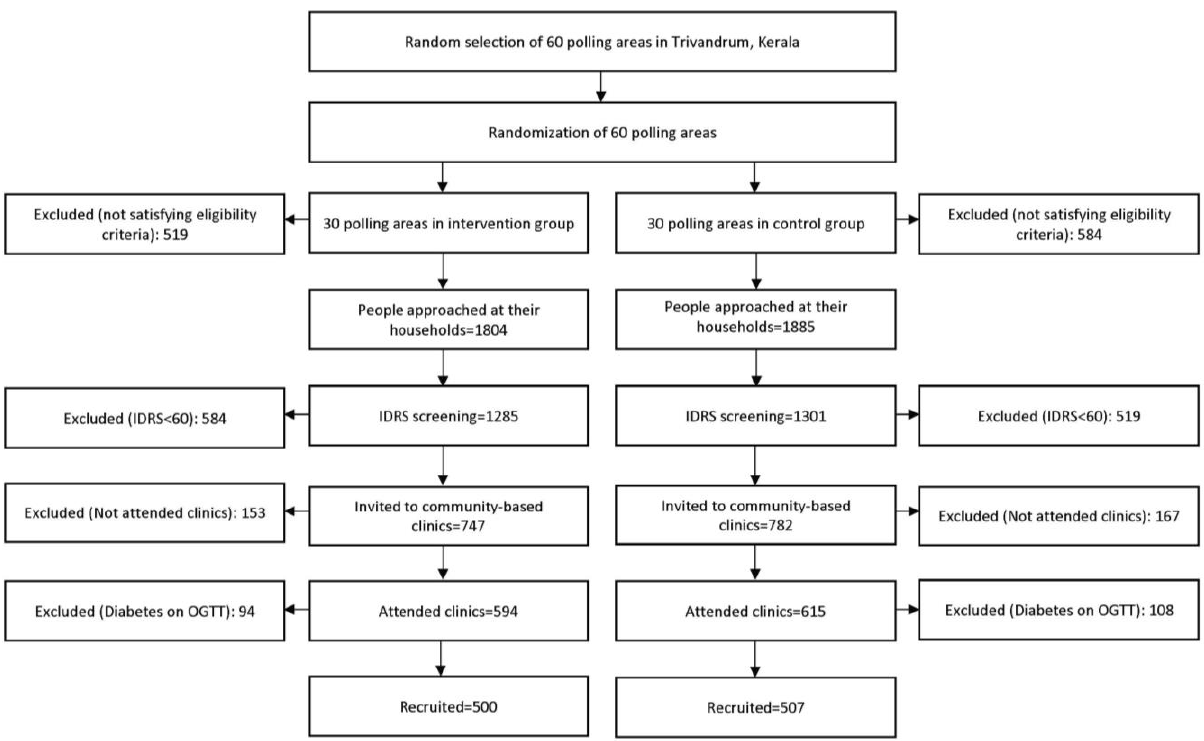
Figure 1. Flowchart showing the screening and recruitment of K-DPP participants. IDRS, Indian Diabetes Risk Score; OGTT, oral glucose tolerance test.